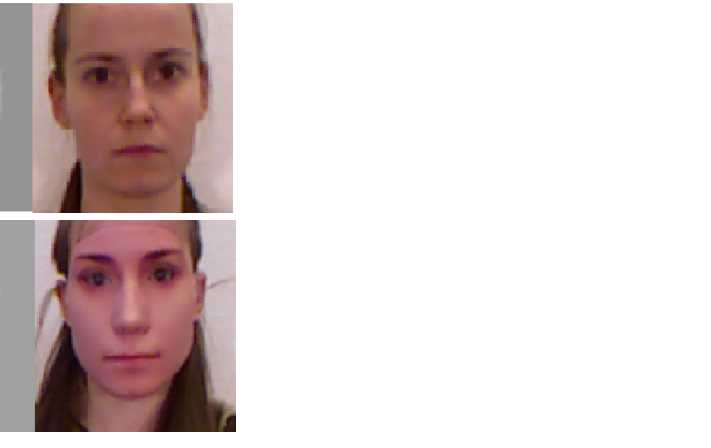
Figure 10. Examples from the 3D Mask Attack Dataset [37]. Depth image ( left ) and RGB image ( right ) of ( a ) real face and ( b ) masked face.